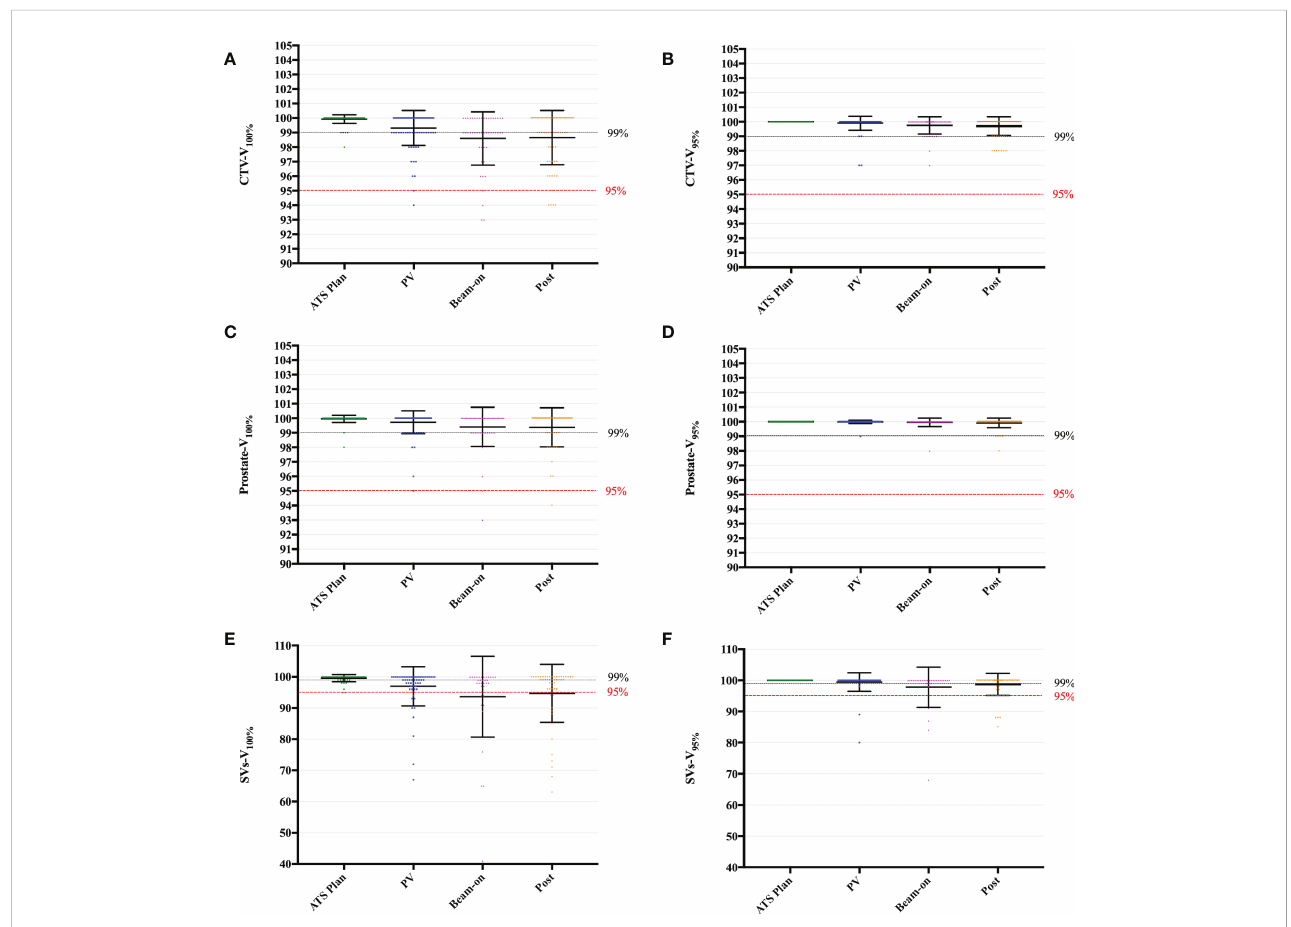
FIGURE 3 Boxplot of V 100% and V 95% values to the CTV (A, B) , Prostate (C, D) and SVs (E, F) , calculated by the daily ATS plan dose on the PV-, Bn- and post-MR scan for each session and patient. Individual data points are shown as dots. The mean ± SD are shown as the error